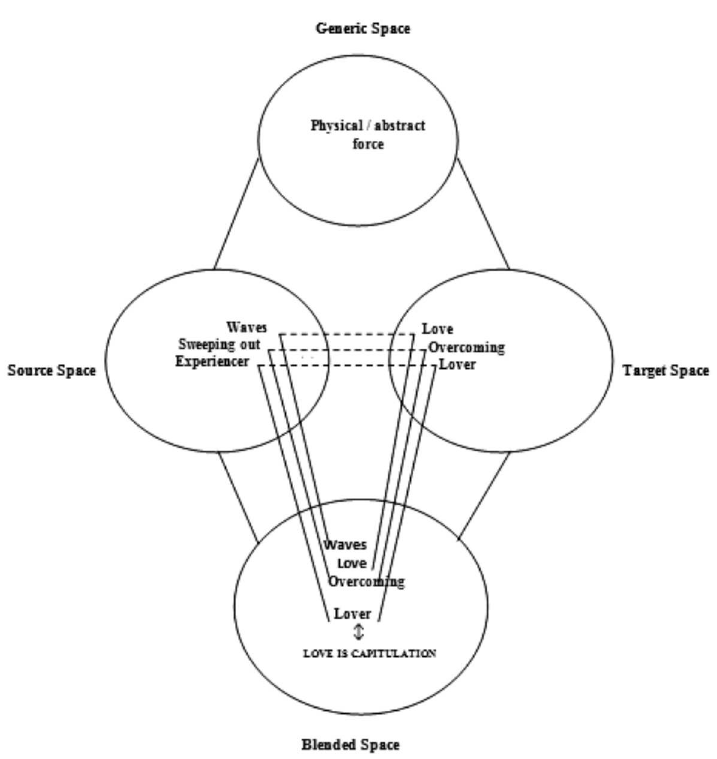
Figure 3. The LOVE IS CAPITULATION